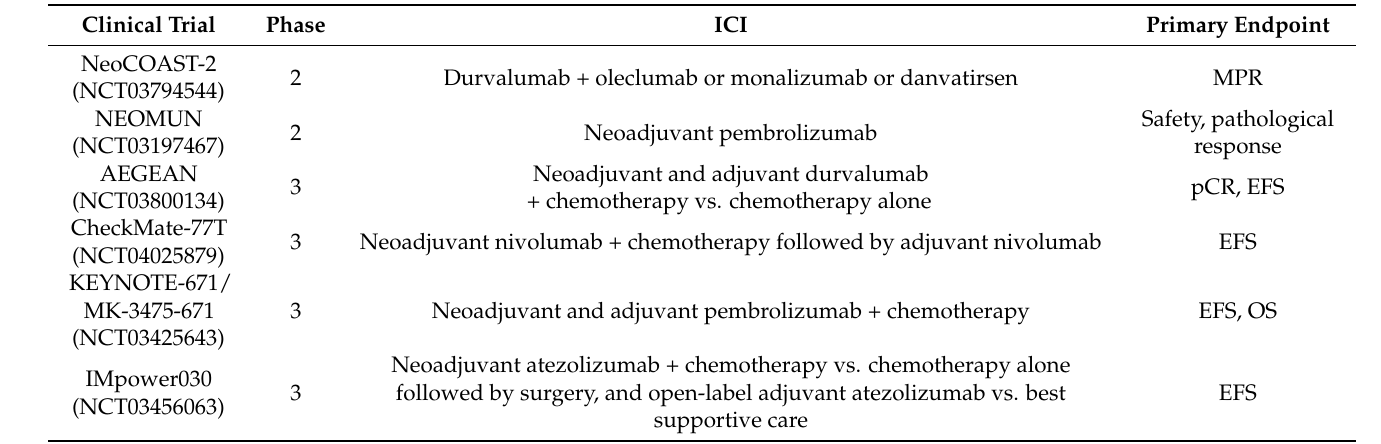
Table 2. Ongoing clinical trials of neoadjuvant immunotherapy in resectable NSCLC. Clinical